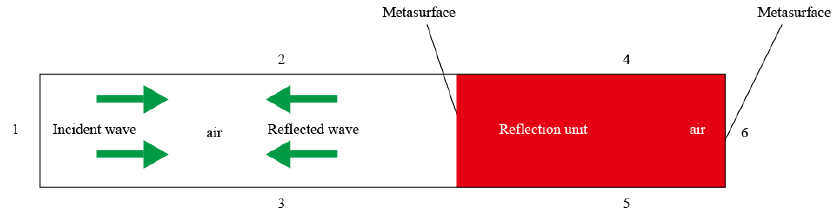
Figure 11. Schematic diagram of plane wave propagation in reflection unit.